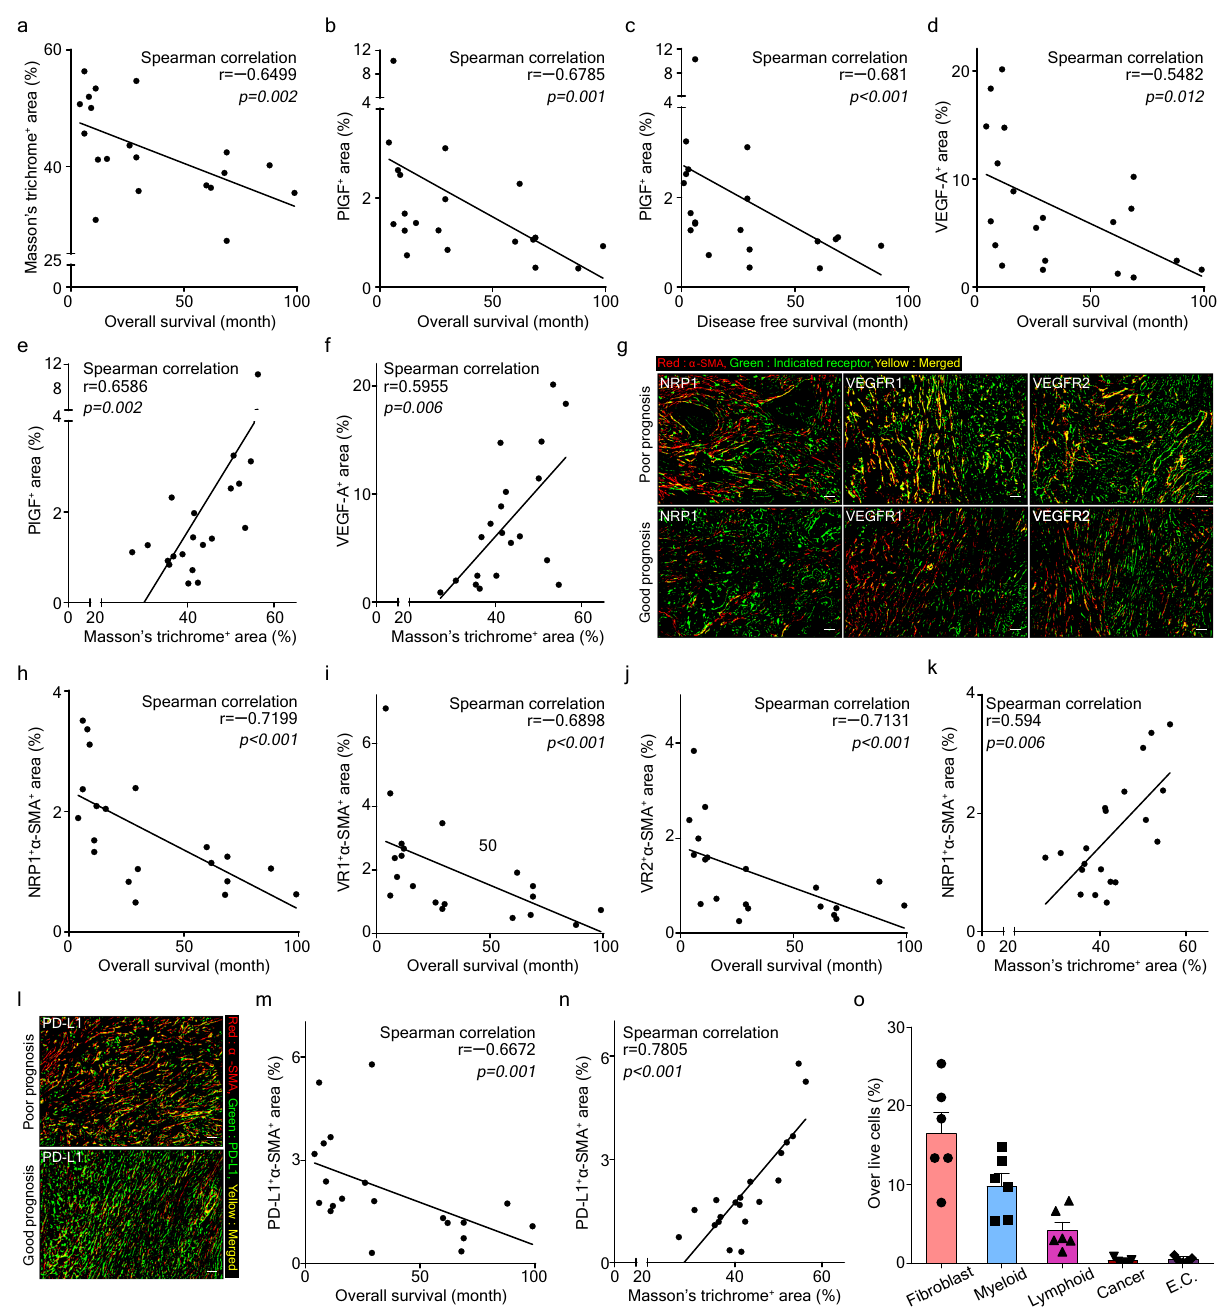
Fig.2|PDACpatientswithpoorprognosishaveelevatedlevelsofintratumoral collagen, PlGF/VEGF-A, and CAFs expressing NRP1/VEGFR1/VEGFR2/PD-L1. Correlation analyses between a tumor fi brosis (measured by Masson ’ s trichrome + area) and overall survival of PDAC patients, between PlGF + area% (detected by IHC staining)and b overallsurvivalor c disease-freesurvivalofPDACpatients,between d VEGFA + area% (detected by IHC staining) and overall survival of PDAC patients, and between tumor fi brosis and e PlGF + area% or f VEGFA + area%. Data from 20 PDAC patient samples were analyzed ( n =20). Statistical signi fi cance was accessed by two-tailedStudent ’ s t test. g Double IHCstaining for α -SMA with NRP1, VEGFR1, orVEGFR2intumorsfromPDACpatientswithpoorprognosisandgoodprognosis. Images were produced via Image J. Red color and DAB color were separated via color deconvolution of IHC images and merged using color merge functions. The red color represents α -SMA in CAFs, the green color represents each indicated receptor, and the yellow color (merged area) indicates co-expression of the two proteins. Four random spots additionally examined showed similar results. Scale